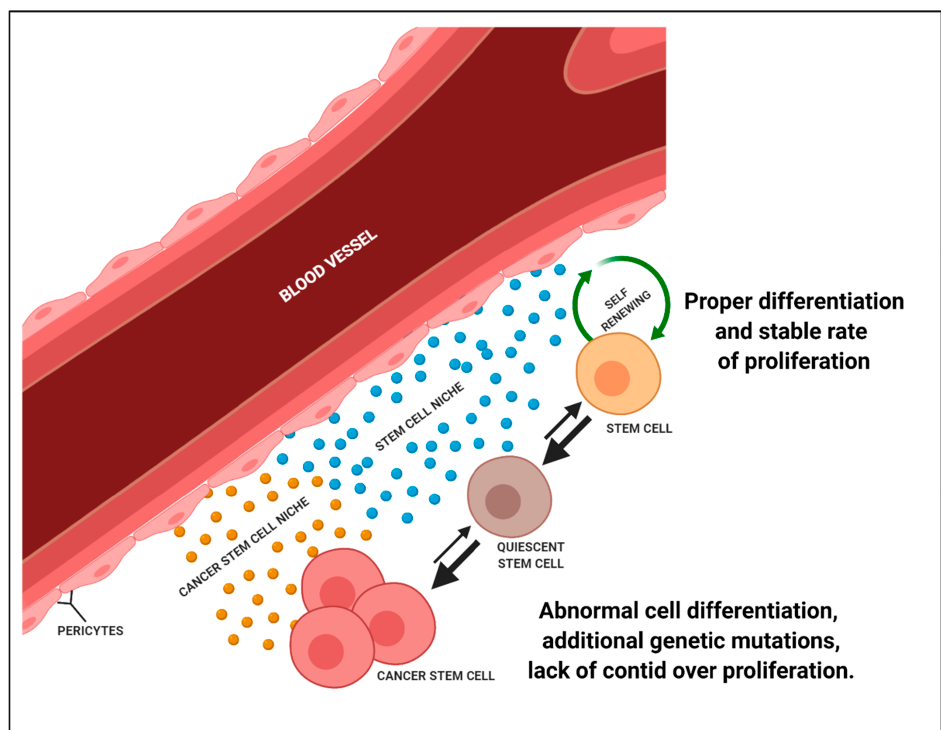
Figure 4. Comparison of functionality of normal stem cell niche and cancer stem cells niche. A niche of stem cells under physiological circumstances provides the cells with conditions in which both cell differentiation and cell proliferation are inhibited. Only during the regeneration of the tissue in which the stem cells are located, a transient signal for proliferation is activated. When appropriate mutations of genetic material develop in the stem cell, they start to proliferate in an uncontrolled way. Another hypothesis assumes that as a result of such a mutation, the niche of the stem cells provides uninterrupted signals that initiate the proliferation and growth of the stem cells. As a result, a large pool of progenitor cells is created, which have a genetic mutation.